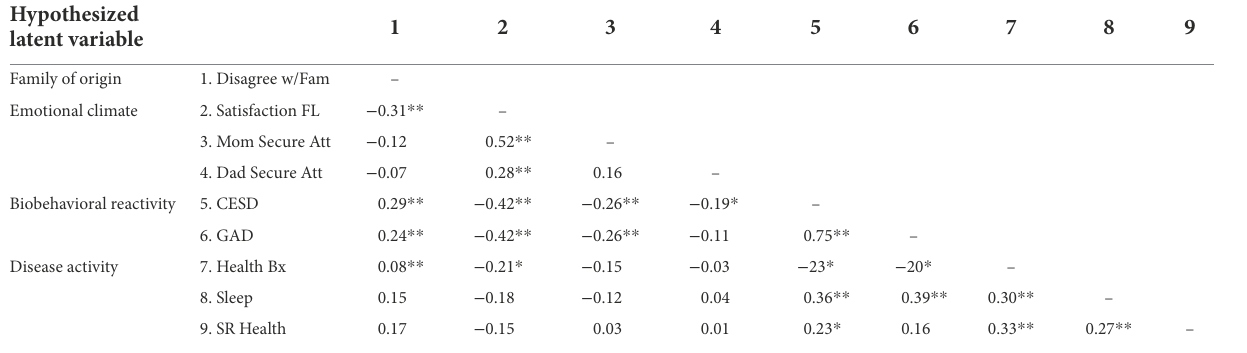
FIGURE 5 Self-comparative health.